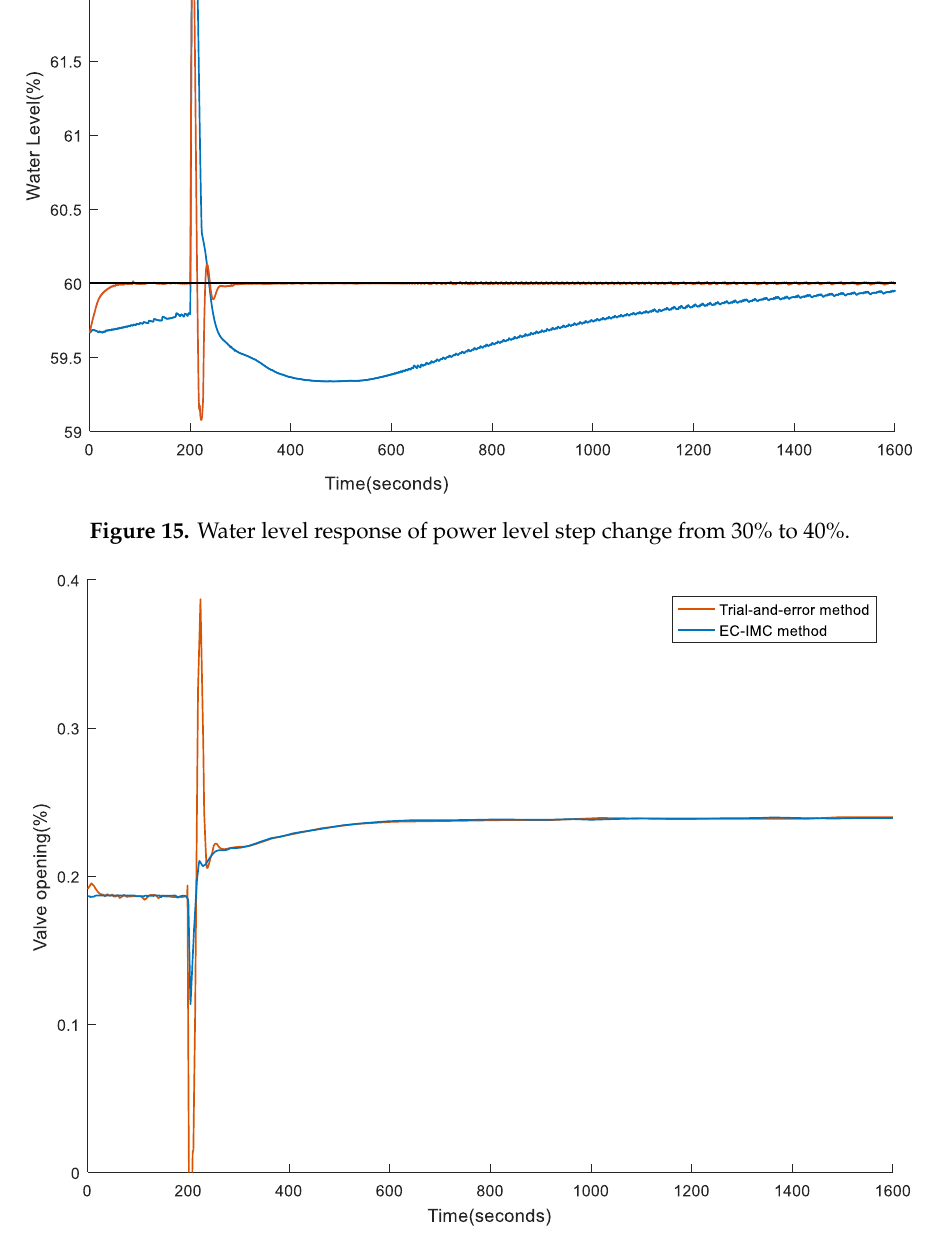
Figure 16. Valve opening response of power level step change from 30% to 40%.